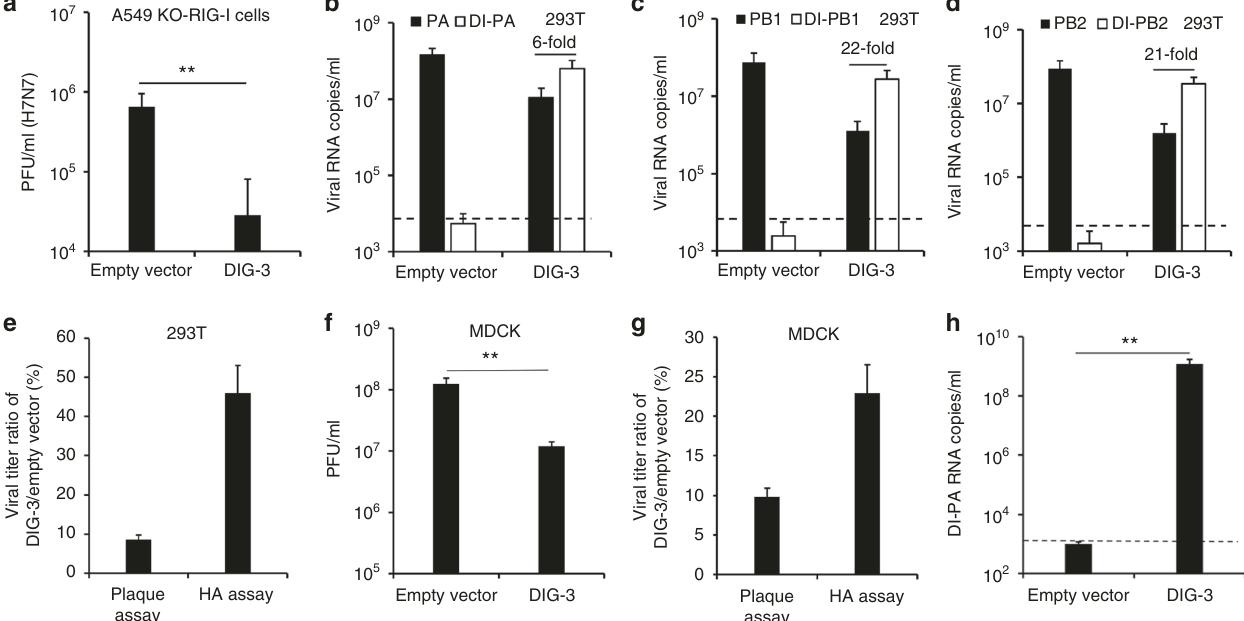
Fig. 2 DIG could be packaged to generate defective interfering virus and competitively inhibit normal viral replication. a Antiviral activity of DIG-3 in A549- Dual KO-RIG-I cells. The A549-Dual KO-RIG-I cells were infected with A(H7N7) virus at 24 h post transfection of empty vector or DIG-3 (0.6 μ g per well). Viral titers in cell supernatants of 40 h post infection were measured by plaque assay. b – d Full-length PA, full-length PB1, full-length PB2, DI-PA, DI-PB1, and DI-PB2 RNA levels in the supernatants of A(H7N7)-infected cells transfected with empty vector or DIG-3 before viral infection. e The percentage of DIG-3-treated virus compared with empty vector-treated virus in supernatants of 293T cells. Viral titers were measured by plaque assay and HA assay. f The passaged viral titers in supernatants of MDCK cells that were infected by the supernatant virus of A(H7N7)-infected 293T cells transfected with empty vector or DIG-3. g The virus titer ratio of DIG-3-treated virus compared with empty vector-treated virus in supernatants of MDCK cells. Viral titers were measured by plaque assay and HA assay. h The DI-PA RNA levels of passaged virus in the supernatants of MDCK cells. Dotted lines indicate the detection limit of RT-qPCR. Data were presented as mean ± SD of three independent experiments. ** Indicates P < 0.01. P values were calculated by